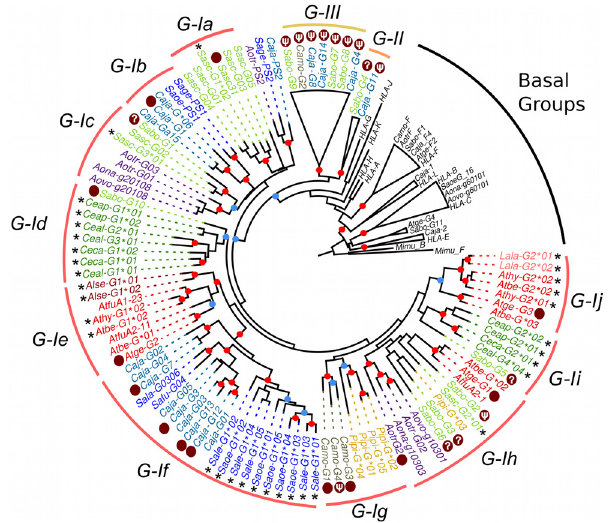
Fig 3. Bayesian phylogenetic tree based on exons 4 – 8 of Platyrrhini MHC-G-like sequences. Sequences marked with an asterisk ( * ) are cDNAs from this work, whereas those marked with a dark red dot are genomic sequences used to assign cDNAs to a given clade. Red dots on the branching points represent a support with a posterior probability > 0.9, and light blue dots represent a support with a posterior probability between 0.7 and 0.9. Lineages and clusters are indicated at the periphery of the tree. Caja, Callithrix jacchus ; Sabo, Saimiri boliviensis ; Sasc, Saimiri sciureus ; Camo, Callicebus moloch ; Pipi, Pithecia pithecia ;